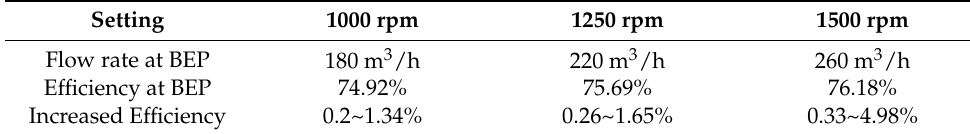
Table 6. Comparison of simulation results at different rotating speed.